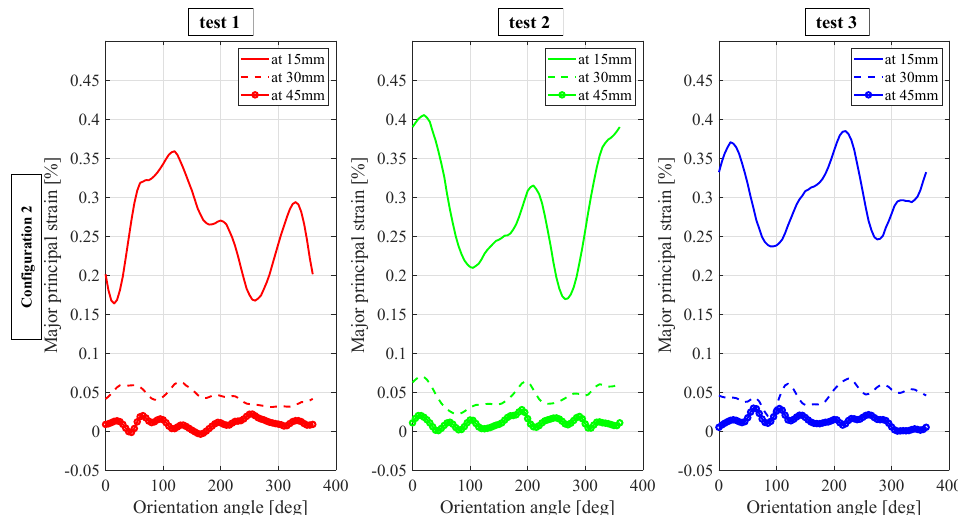
Figure 10. Major principal strains of points placed on a circle of a given radius (15 mm, 30 mm or 45 mm) from the impact center as a function of their orientation angle for the three tests of configuration 2 and shows the influence of FSP orientation at the moment of impact on the amplitude of the major principal